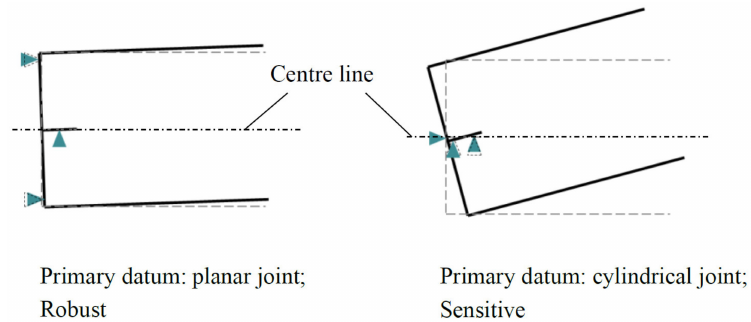
Figure 3. Variation comparison under different positioning strategies.